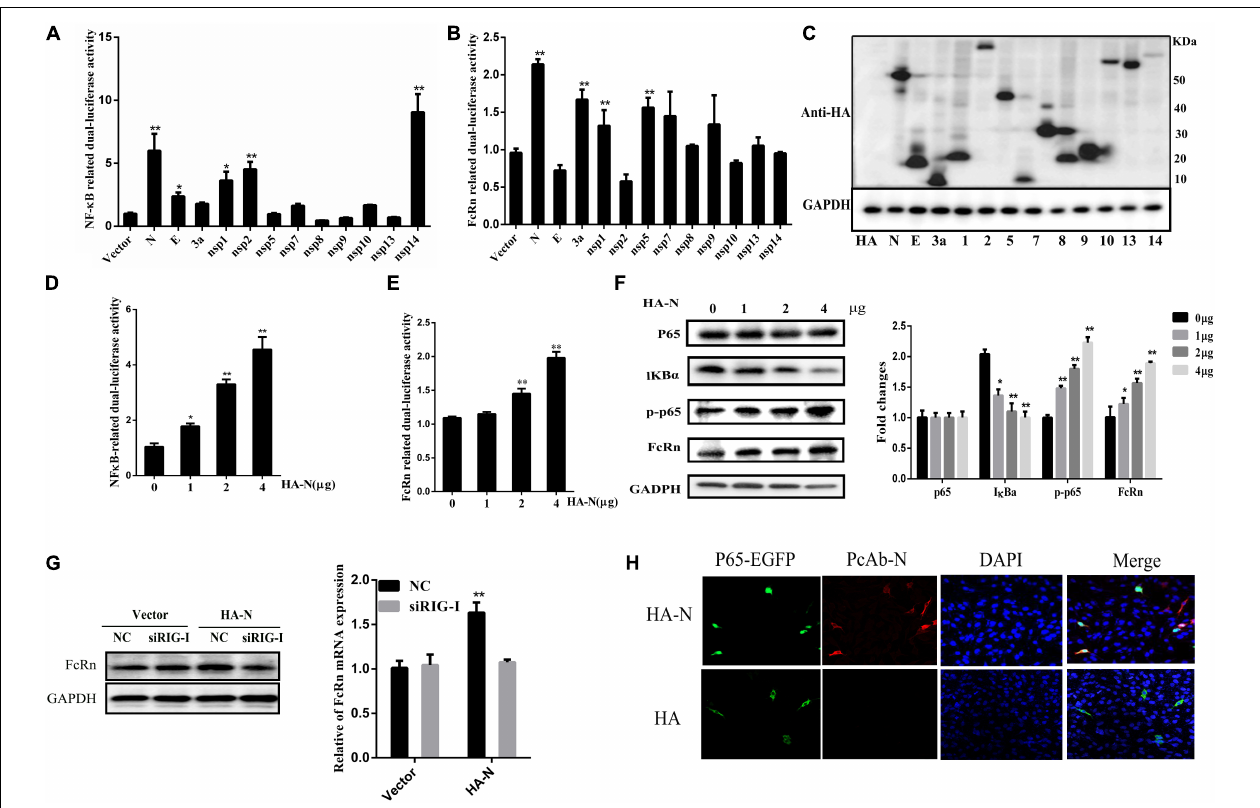
FIGURE 4 | Transmissible gastroenteritis virus N induces FcRn and NF- κ B activation. (A,B) IPEC-J2 cells were co-transfected with pRL-TK and FcRn-Luc or NF- κ B-Luc together with each expression plasmid of TGEV proteins. (C) Lysates of transfected cells were subjected to Western blot with anti-HA antibody to detect viral protein expression. (D,E) IPEC-J2 were co-transfected with pRL-TK, FcRn-Luc or NF- κ B-Luc, and TGEV N expression plasmids (1, 2 or 4 µ g) for 36 h. The cell lysates were analyzed by dual-luciferase assay. (F) FcRn, I κ B α , p65 and phosphorylated p65 (p-p65), and GAPDH was assayed by Western blot analysis. (G) IPEC-J2 cells were transfected with siRIG or NC siRNA for 24 h and subsequently retransfected with TGEV N-expression plasmids (4 µ g) for an additional 24 h. FcRn expression were detected by Western blot analysis. The right panel represents the quantification of the bands by densitometry, corrected by the amount